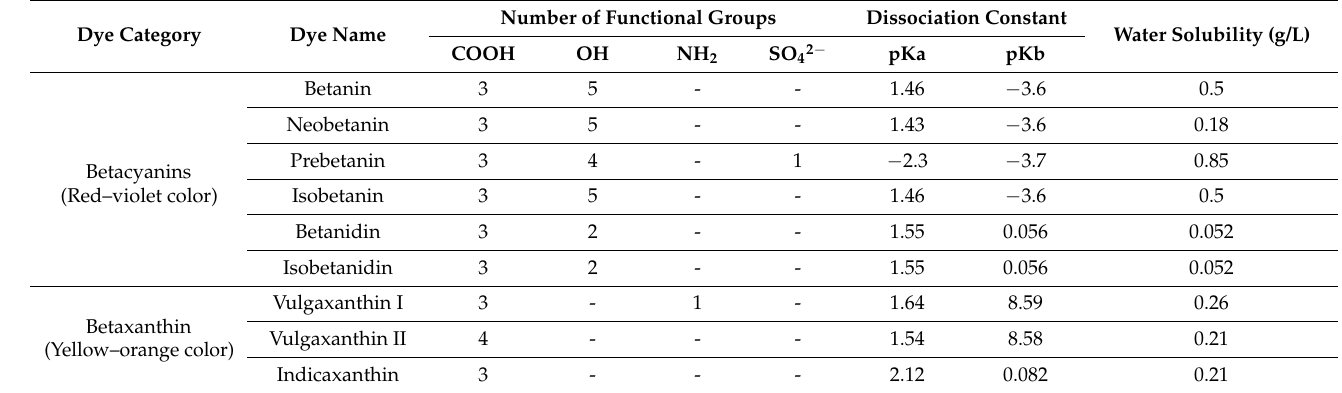
Table 2. Characteristics of